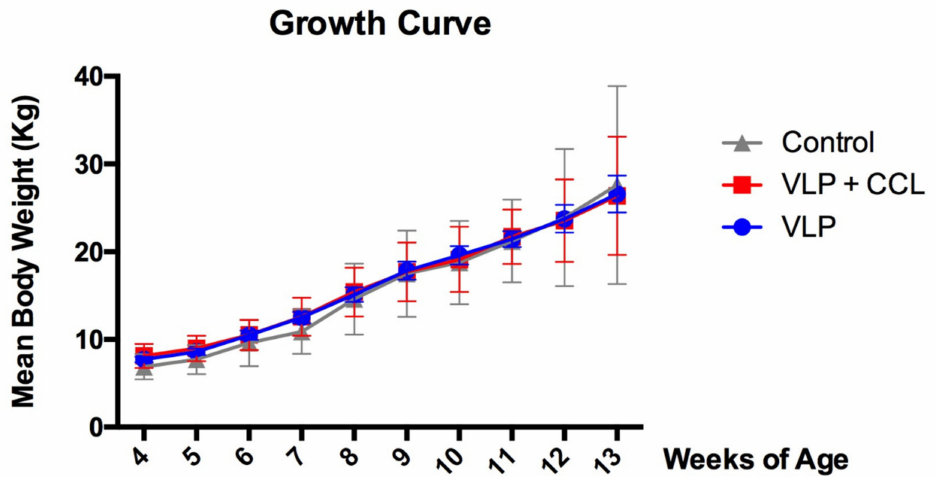
Figure 6. Changes of the weekly body weight. The body weights of all pigs in each group were measured every week. The weekly averaged body weights in each group are demonstrated as mean ± SEM. The mean values in control, VLP, and VLP + CCL groups are presented as gray, blue, and red lines,